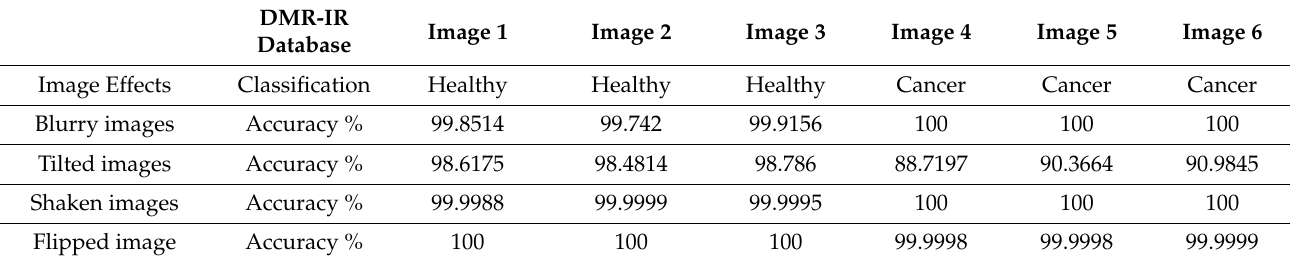
Table 6. Detection accuracy of thermal images (DMR- IR DATABASE ) after